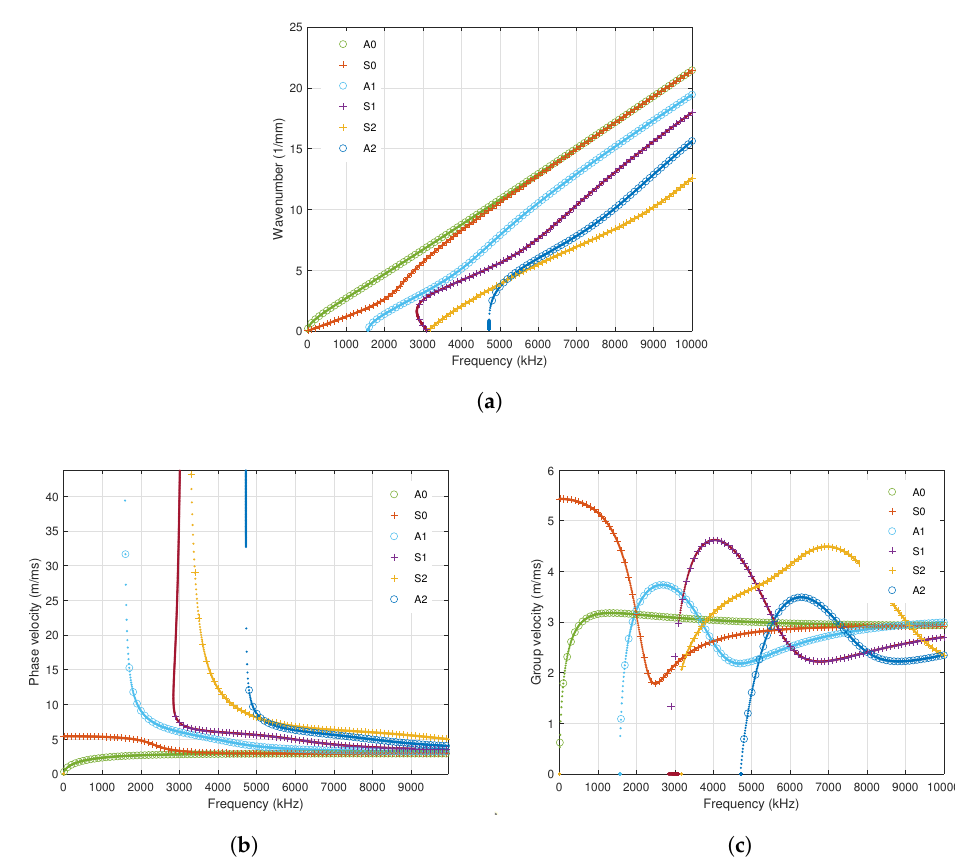
Figure 4. Dispersion curves of the first six modes of propagating Lamb waves in a 1mm thick aluminum plate; · · · Dispersion Calculator, + SAFE method (symmetric modes), o SAFE method (anti-symmetric modes); ( a ) wavenumber, ( b ) phase velocity, ( c ) group velocity vs.